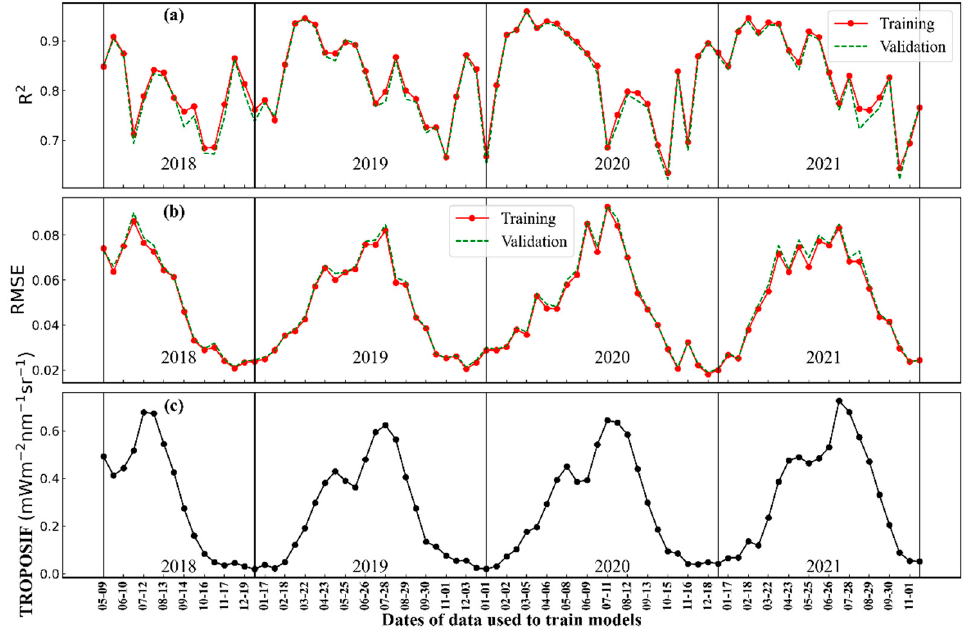
Figure 2. ( a ) The determination coefficient R 2 and ( b ) RMSE of TROPOSIF and predicted TSIF for training and validation; ( c ) The TROPOSIF mean of all SIF pixels within MODIS tile grid H27V05.